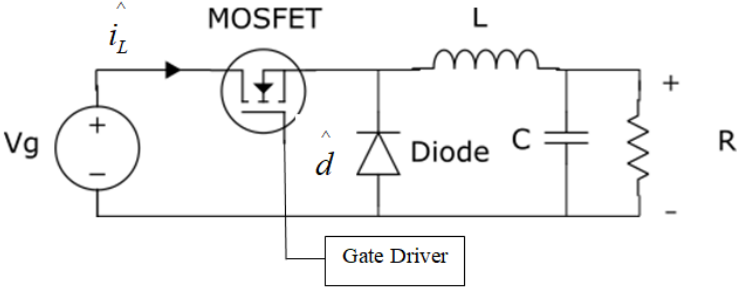
Figure 2. Schematic of ACC in open loop [3].